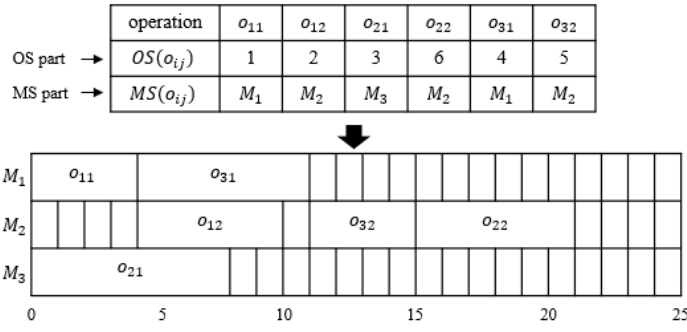
Figure 1. Decoding the multichromosome representation for the FJSP.